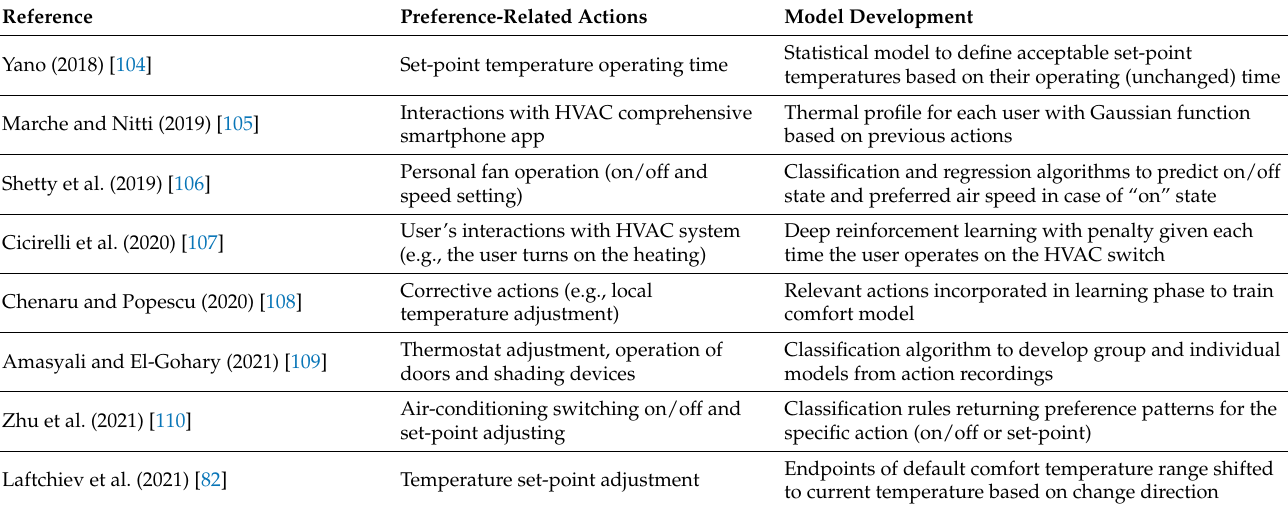
Table 8. Thermal comfort models based on occupants’ actions in reviewed